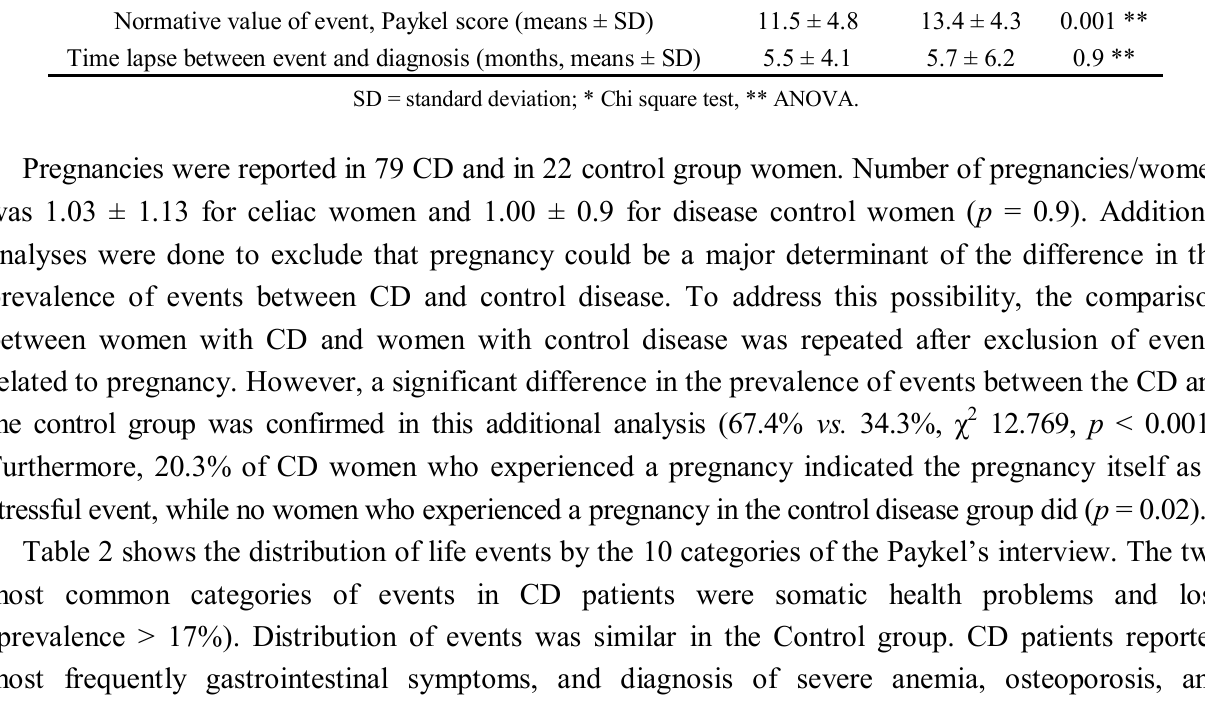
Table 1. Reported number of events according to the Paykel’s interview, time lapse from the event to the diagnosis, and normative values (the standardized weight of each event in the scale) in coeliac disease (CD) and control gastroesophageal reflux disease (GERD) subjects. Variables CD GERD p Number of patients 186 96 % with events 67.2% 37.5% <0.001 * Normative value of event, Paykel score (means ± SD) 11.5 ± 4.8 13.4 ± 4.3 0.001 ** Time lapse between event and diagnosis (months, means ± SD) 5.5 ± 4.1 5.7 ± 6.2 0.9 ** SD = standard deviation; * Chi square test, ** ANOVA.